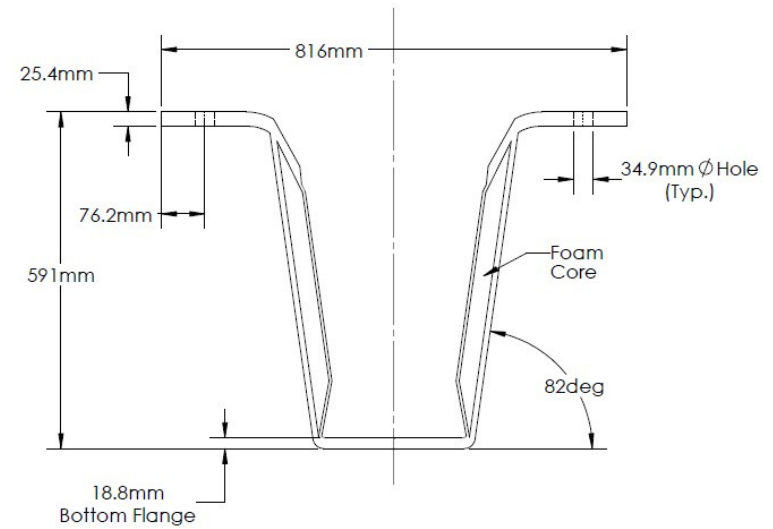
Figure 2. FRP Test Girder Cross-Section.